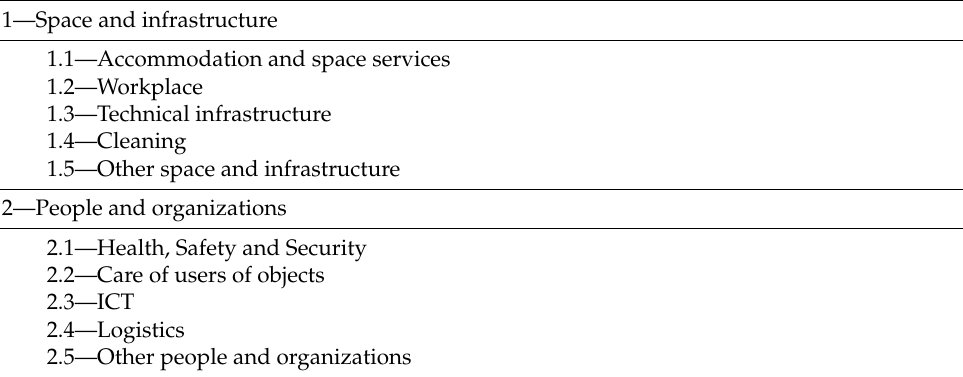
Table 3. Basic breakdown of FM activities according to the ˇCSN EN 15221-4 standard. Source: authors according to [65,66].